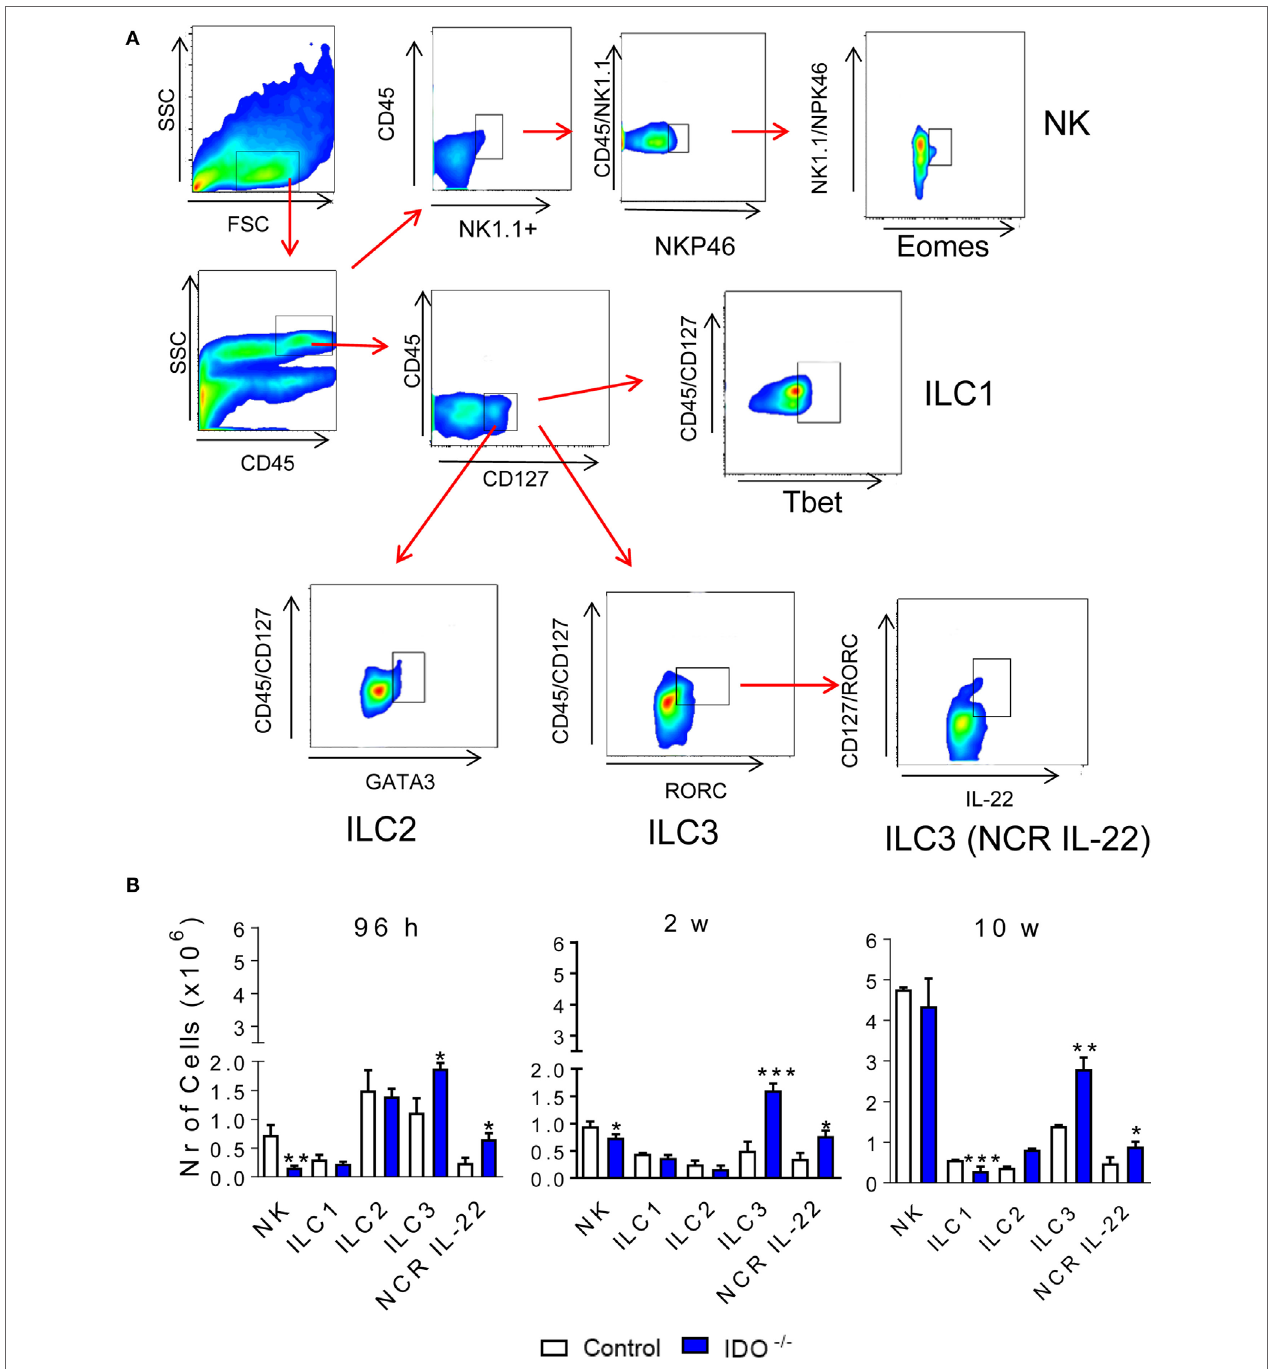
FigUre 2 | Influence of indoleamine 2,3 dioxygenase-1 (IDO1) expression on the presence of innate lymphoid cells (ILCs) in the lungs of Paracoccidioides brasiliensis -infected mice. The phenotypic analysis of ILCs in the lungs of C57Bl/6 wild-type and IDO1 − / − mice was performed after 96 h, 2, and 10 weeks after P. brasiliensis infection. The lung infiltrating leukocytes were labeled with specific antibodies and analyzed for the phenotypes of NK, ILC1, ILC2, innate lymphoid cell 3 (ILC3), and ILC3 (NCR IL-22) subsets according to the respective markers: for NK: NK1.1, CD49b, NKp46, and Eomes; ILC1: CD127, CD49a, IL-12R β 1, and Tbet; ILC2: CD127, ICOS, IL-17RB, IL-33, and GATA3; ILC3: CD127, IL-23R, IL-22, and RORC (a) . The cell surface and intracellular markers were measured by flow cytometry. One hundred thousand cells were counted and the data expressed by number of positive cells (B) . Data are expressed as means ± SEM and are representative of three independent experiments using five mice of each mouse strain per group (* p < 0.05; ** p < 0.01, and *** p <